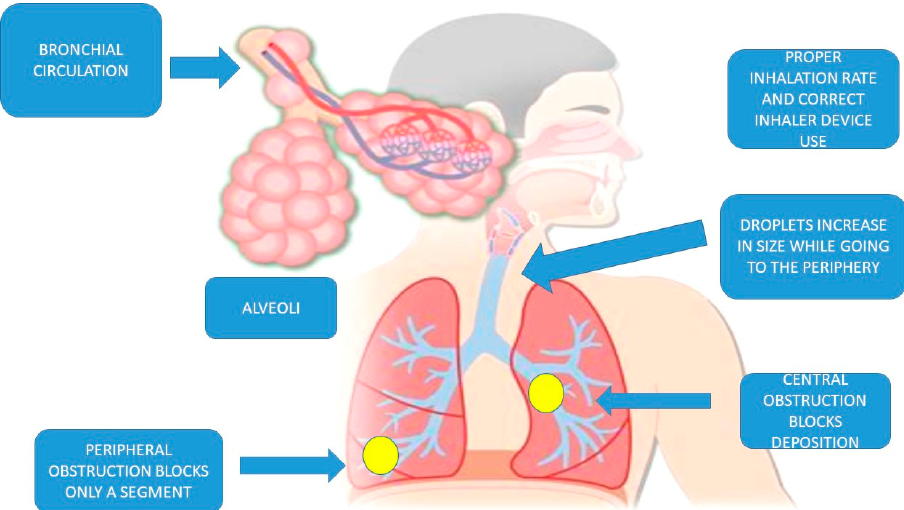
Figure 2. Schematic of parameters affecting the optimal administration and where in the airways. The correct use of an inhaler along with the correct inhalation force is essential for the best drug deposition. A central obstruction blocks the deposition of the aerosol drug in a lung or lobe, while a peripheral obstruction blocks a lobe or only a small segment of the lobe. The bronchial circulation in the alveoli is responsible for the systematic absorption of the inhaled drug.